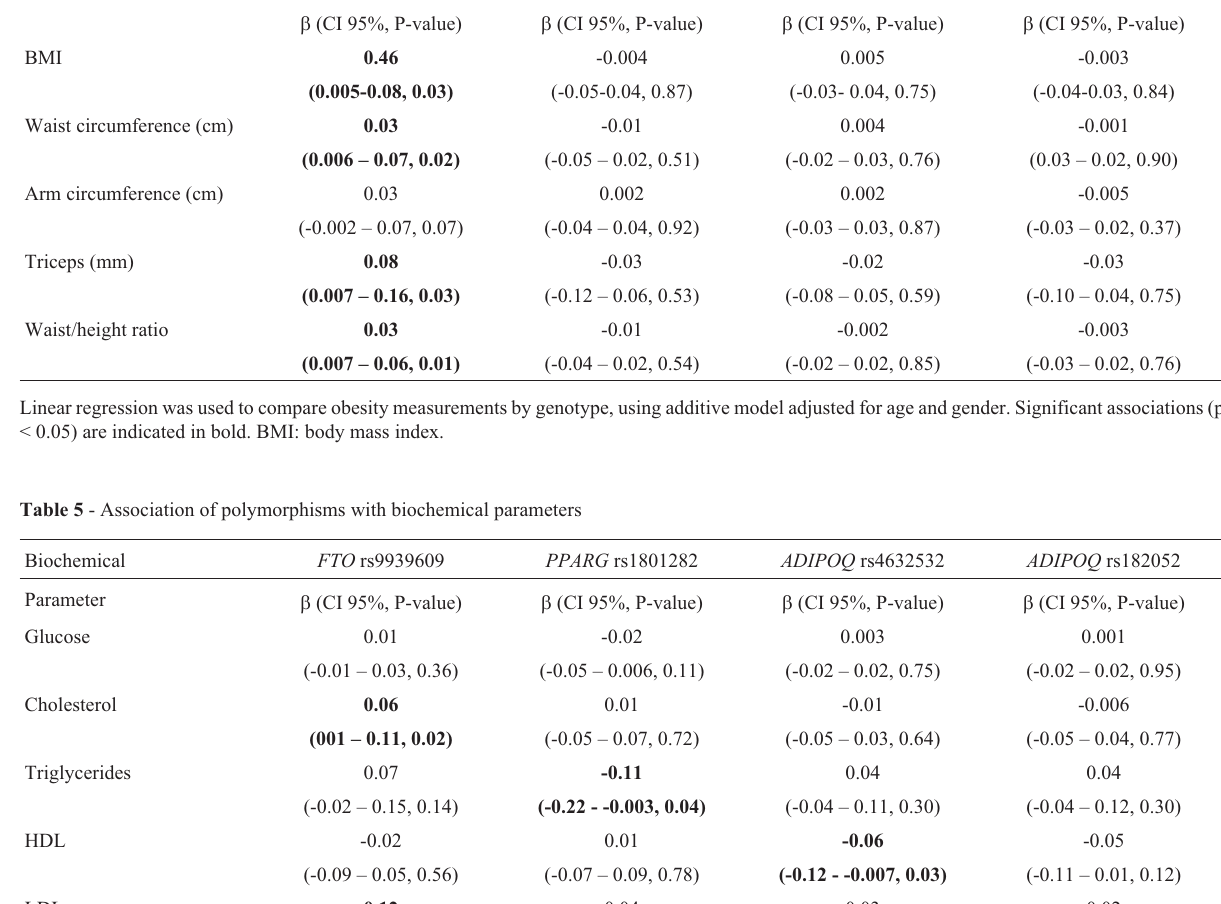
Table 4 - Association of polymorphisms with obesity-related traits Measurements